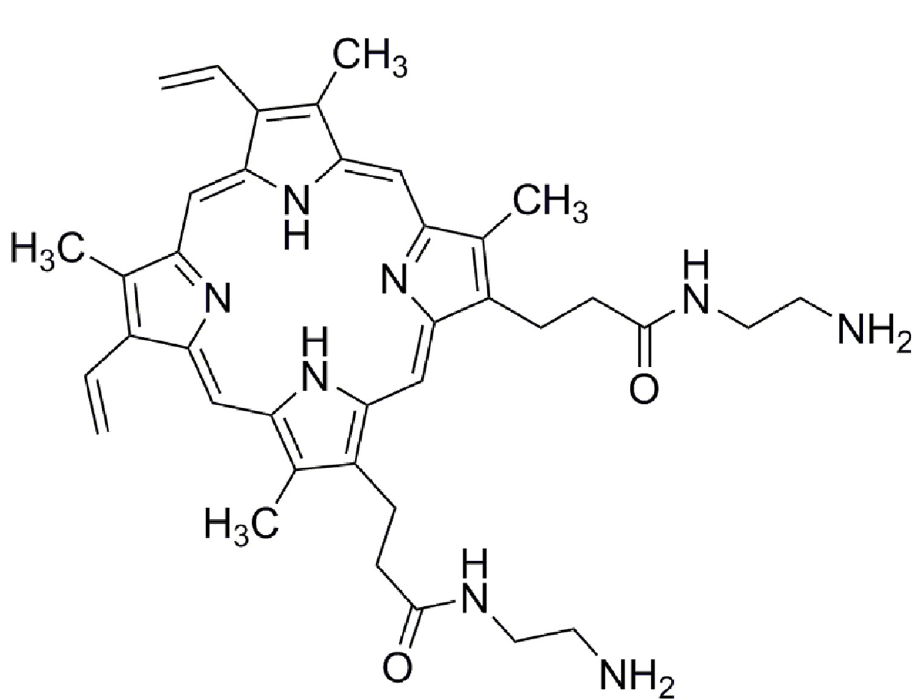
Fig 2. Structure of N , N 0 -bis (2-aminoethyl) -2,7,12,18-tetramethyl-3,8-divinyl-21 H , 23 H -porphyrin- 13,17-bispropanamide porphyrin (PPIX-ED).